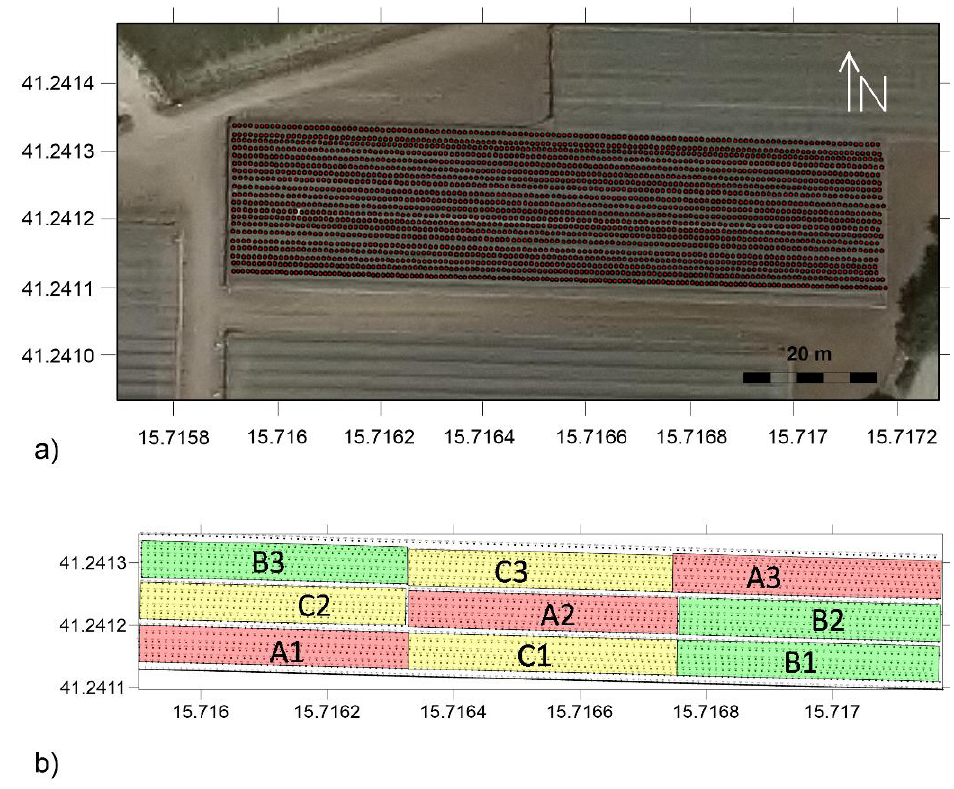
Figure 4. ( a ) Distribution of EMI point measurement location in the experimental area and ( b ) partitioning of the experimental area in nine plots with different irrigation setup. Table 4. Details of the EMI campaigns: date, starting and ending time of acquisition; and number of point measurements for each